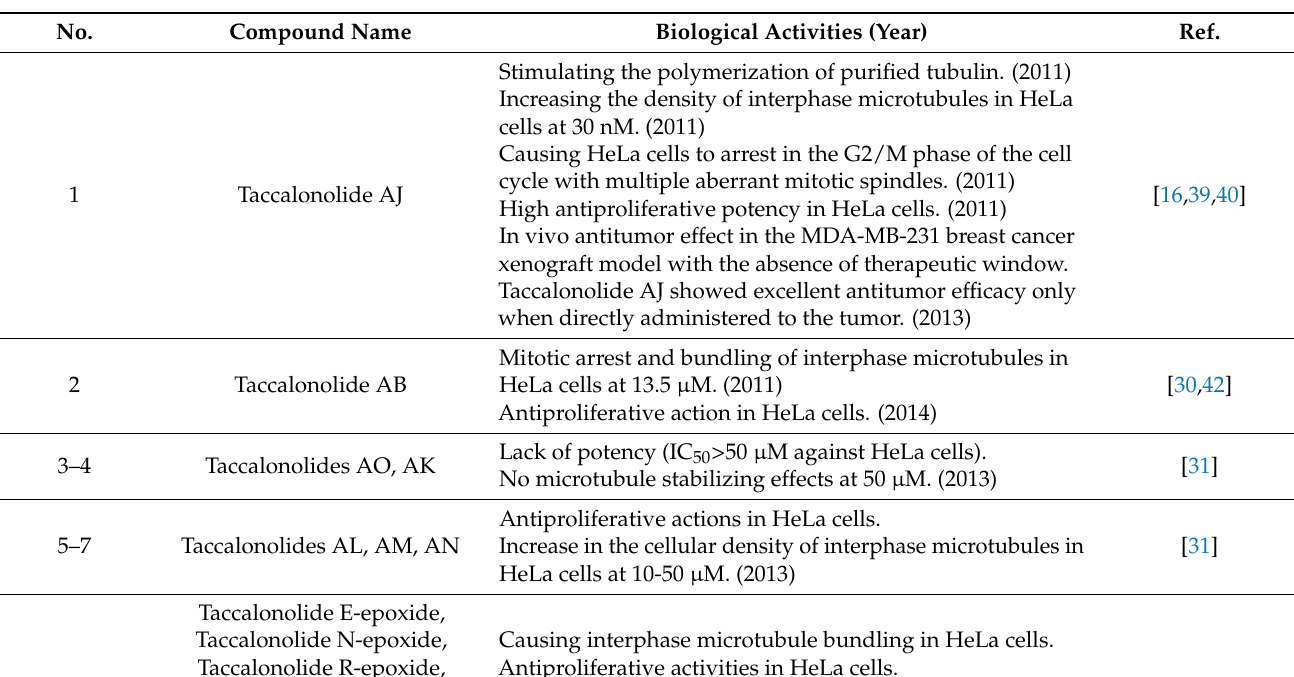
Table 3. Semi-synthetic taccalonolides based upon naturally occurring